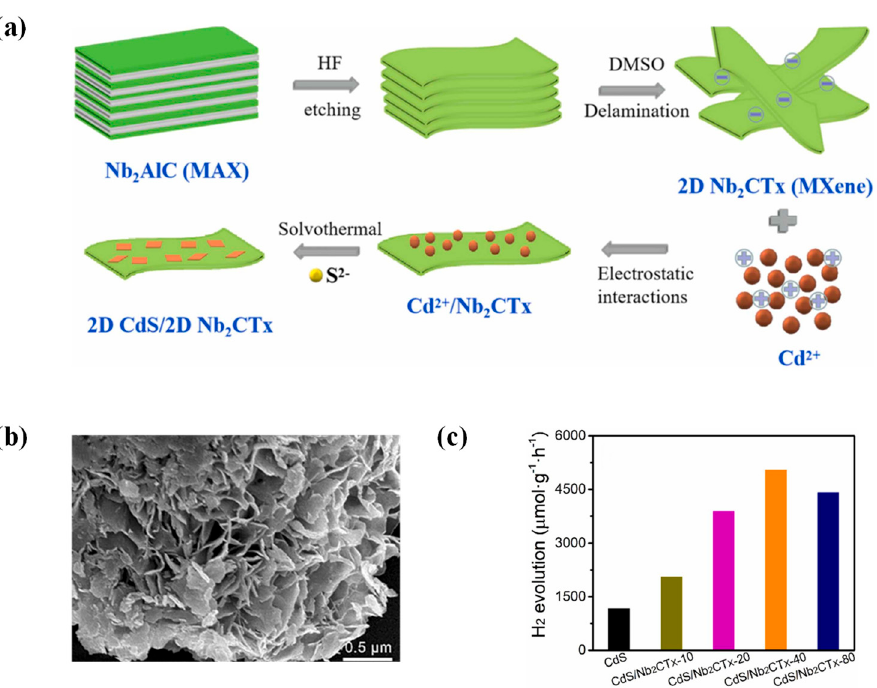
Figure 12. Applications of Nb 2 CT x in photocatalyst. ( a ) Schematic illustration of fabrication proce- dure of CdS/Nb 2 CT x , ( b ) SEM image of CdS/Nb 2 CT x -40, ( c ) Photocatalytic H 2 evolution rates of CdS and CdS/Nb 2 CT x . [64] Copyright Elsevier, 2022.